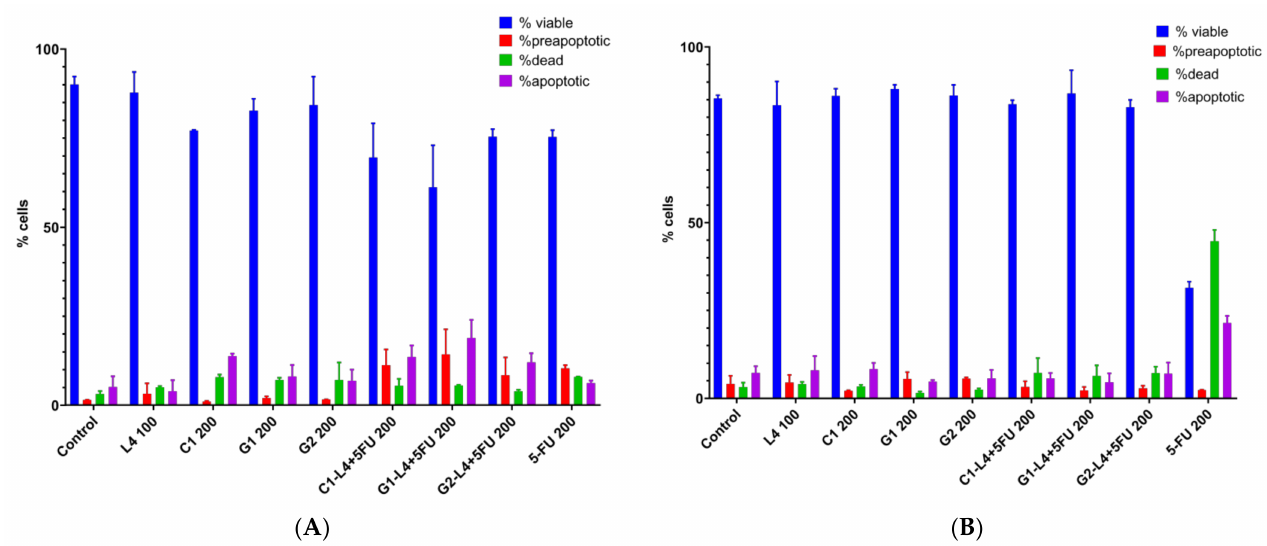
Figure 7. Percentage distribution of the viable, dead, apoptotic and preapoptotic cells after 24 h ( A ) and 48 h ( B ) as quantified by Annexin V-FITC and propidium iodide in apoptosis assay according to every experimental